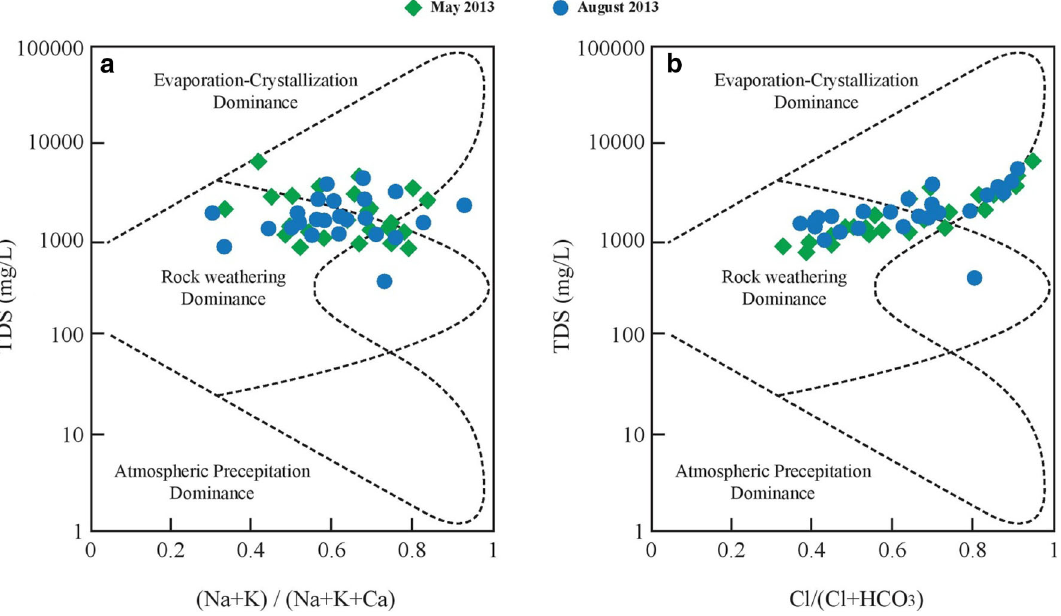
Fig. 7 Mechanism controlling the groundwater in the Amaravathi River